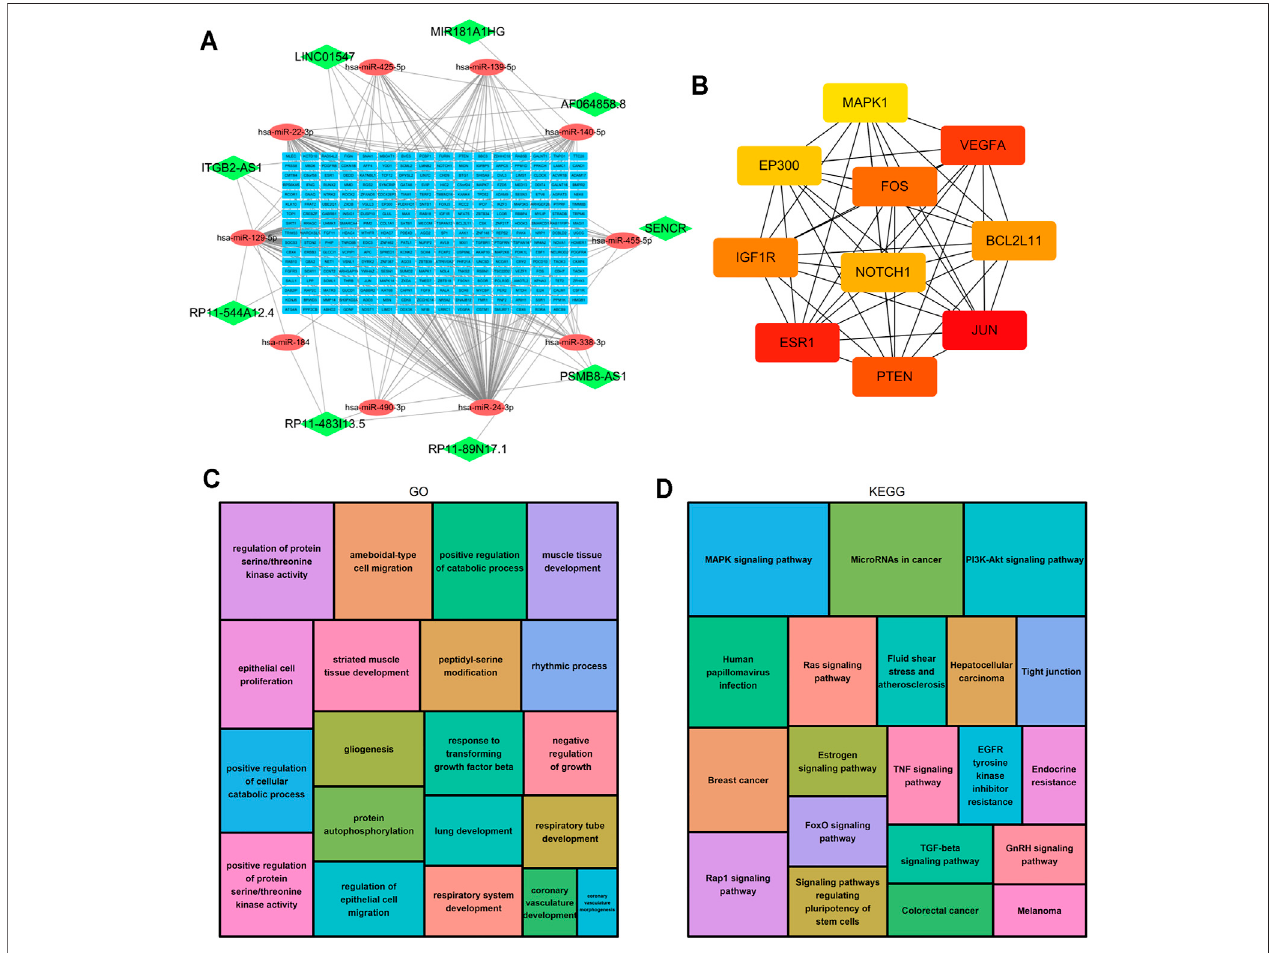
FIGURE 10 | Construction of the ceRNA network and functional enrichment analysis. (A) The ceRNA network of lncRNAs (green diamonds), target miRNAs (red circles) and mRNAs (blue rectangles). (B) 10 hub genes were extracted from the PPI network. (C) GO functional annotation showed the top 20 enriched biological processes. (D) KEGG pathway analysis showed the top 20 enriched